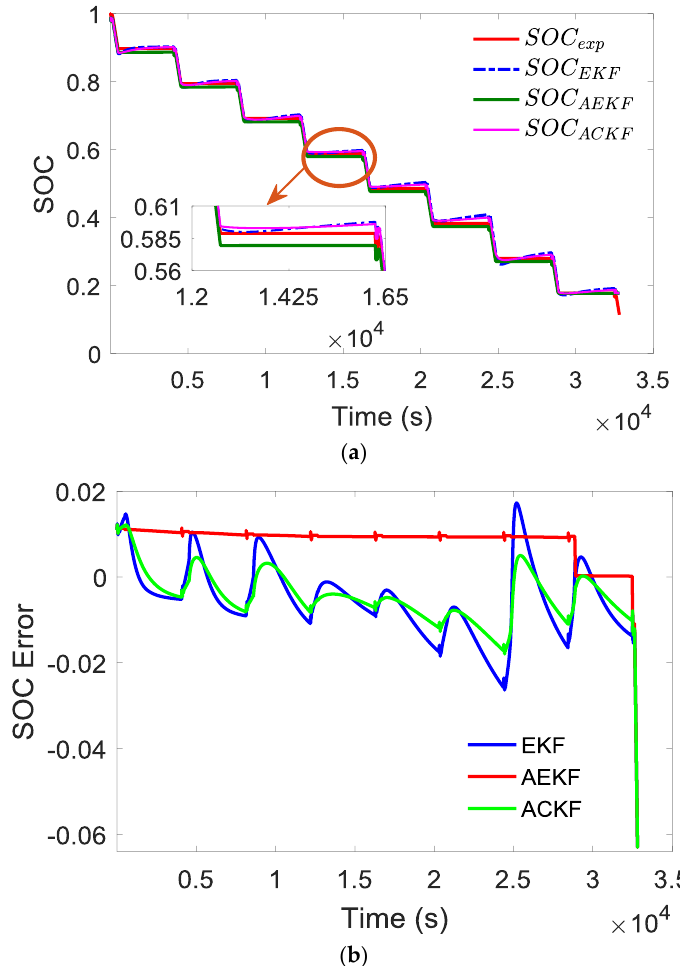
Figure 12. Validation results for SOC estimation under HPPC condition at 30 °C: ( a ) SOC estimation profiles with different methods; and ( b ) SOC errors.